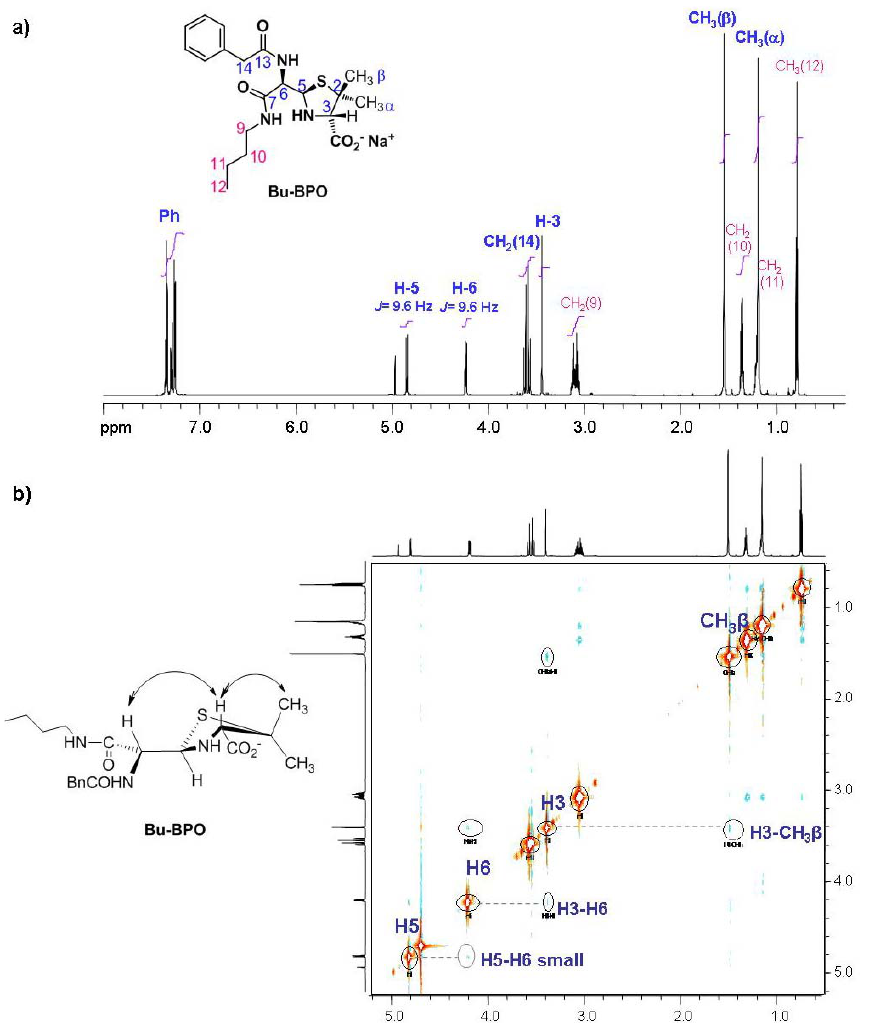
Figure 1. ( a ) 1 H NMR spectra of Bu-BPO in D ( b ) Representation of NOE effects of Bu-BPO structure and expansion of its NOESY